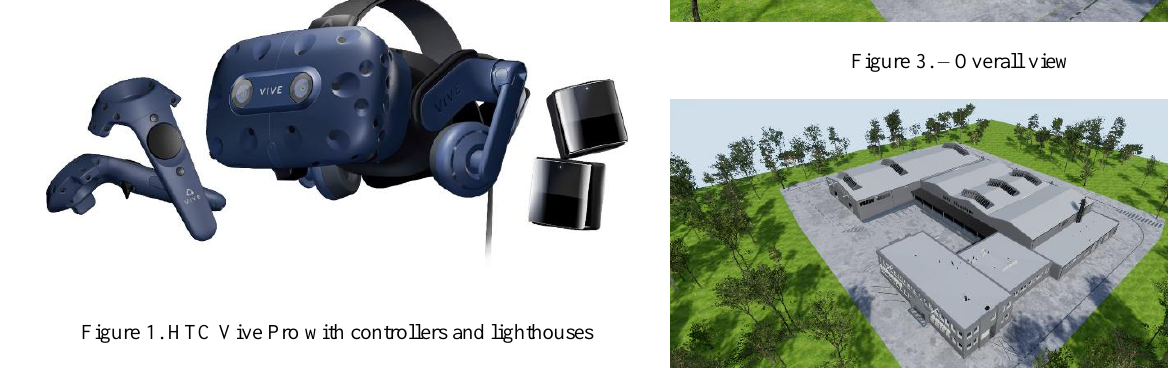
Figure 3. – Overall view